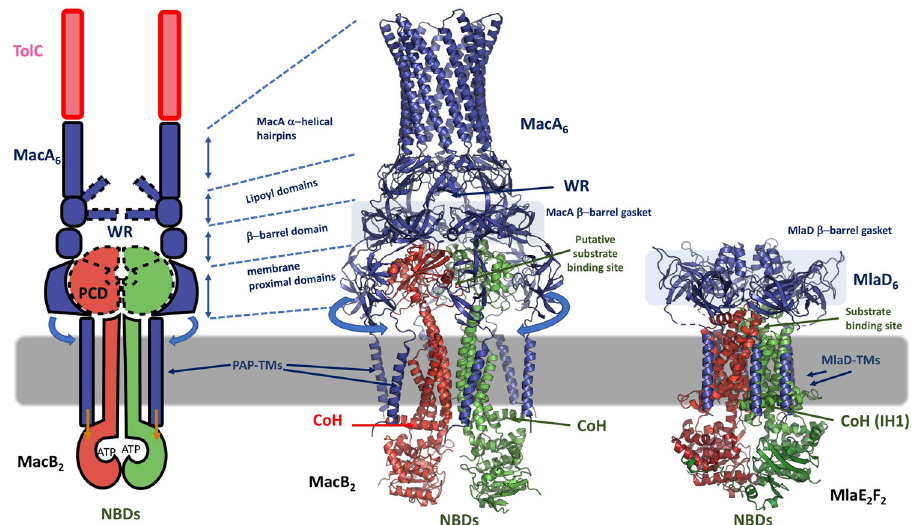
Fig. 4 Communication across the membrane facilitated by the transmembrane helices of the periplasmic adaptor proteins and the TMD and connecting helices of the transporter may provide the additional long-range allosteric coupling that accounts for the additional energy input provided by ATP-hydrolysis power stroke. Left panel, schematic representation of the MacAB-subcomplex, similar to Fig. 3 above, with key structural elements being shown. The TM-helices of MacB play a central role in mechanotransmission 3,5,8 , however, the holistic view of the MacAB-transporter unit also requires taking into account the allosteric signaling by the MacA-component (indicated by the blue and orange arrows). While a large body of functional data exists that demonstrates the involvement of the MacA in the allosteric signaling and in particular the involvement of its TMs in communication of the ATPase-stimulatory signal to the dimerised NBDs of MacB 10,12,13 , so far there has been no structural rationale for it. Recent structure solution of MlaFEDB complexes 45,46,52 , (here, PDB ID 6XBD pictured, on the right), provide unexpected analogy in structural and functional organization with MacAB- subcomplex. Within these complexes, the TM-helices of the adaptor-protein MlaD form distinct contacts with the TMD and Connecting Helices (CoH) of the ABC transporter MlaEF. These contacts have been shown to be critical for ATPase function and coupling of substrate-extrusion. While currently available crystal and cryo-EM structures 8,9,53 do not contain structurally-resolved MacA TM-domains, modelling of the full-length MacA based on the available overall structure of MacAB-TolC complex (PDB ID 5NIK; central panel, cartoon representation), demonstrates that the TM-helices plausibly contact the coupling helix (CoH) and/or the intramembrane helices of MacB, which could provide a mechanistic explanation to the requirement of these MacA TM-segments for activation of ATPase-activity of MacB 10 . The TolC and MlaB subunits of the MacAB-TolC and MlaEFDB complexes are not drawn for clarity, in the central and the right panels, respectively. WR abbreviation indicates the “ waiting room ” cavity formed between the MacA hexamer and MacB PCD